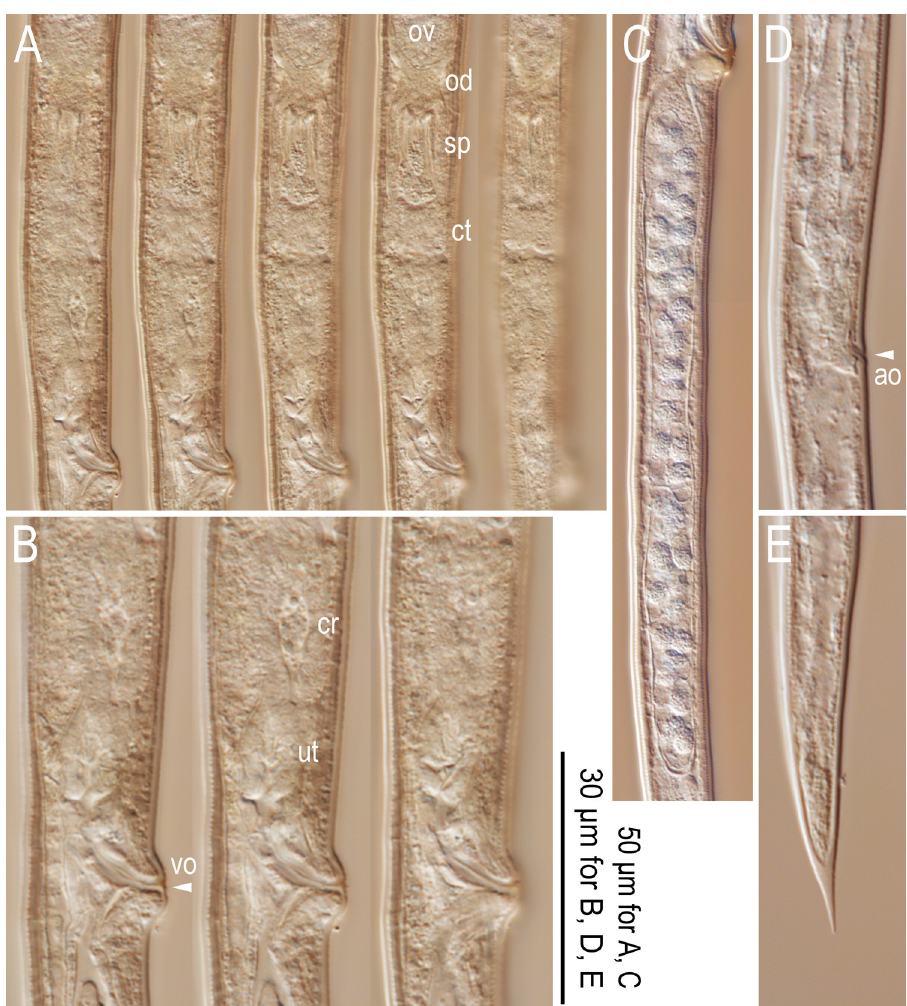
Fig 5. Light micrographs for female Bursaphelenchus suri n. sp. A: Ovary to vulval region in five different focal planes (ov = ovary; od = oviduct; sp = spermatheca; ct = connective tissue); B: Vulval region in three different focal planes (vo = vulval opening; cr = crustaformeria; ut = uterus); C: Post-uterine sac; D: Anal region (ao = anal opening); E: Tail tip. All subfigures are in right lateral view.